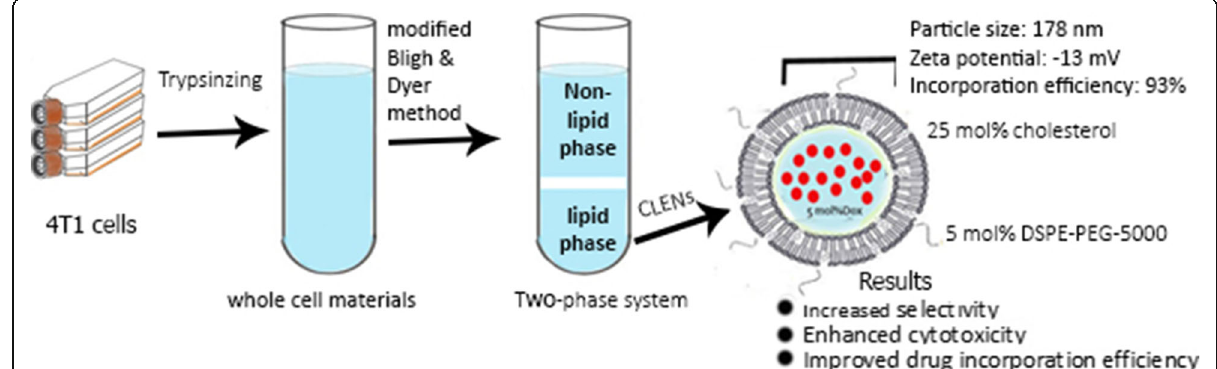
Fig. 7 Isolation of lipid extracts from target cells in preparation of CLENs. The schematic shows the process for preparing CLENs from isolation of the chloroform-soluble fraction which corresponds to the lipid extract phase mixture. The inclusion of cholesterol and DPPE-PEG 5000 in CLENs improved drug incorporation, stability, cellular uptake, and cytotoxicity among other formulation